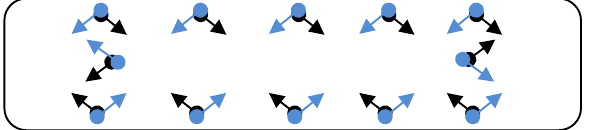
Figure 9. photography positions for a wide corridor.